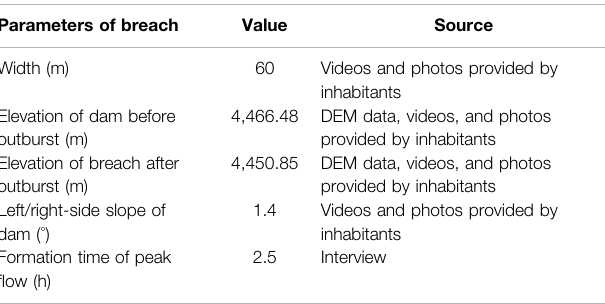
TABLE 3 | Parameters of moraine-dam.